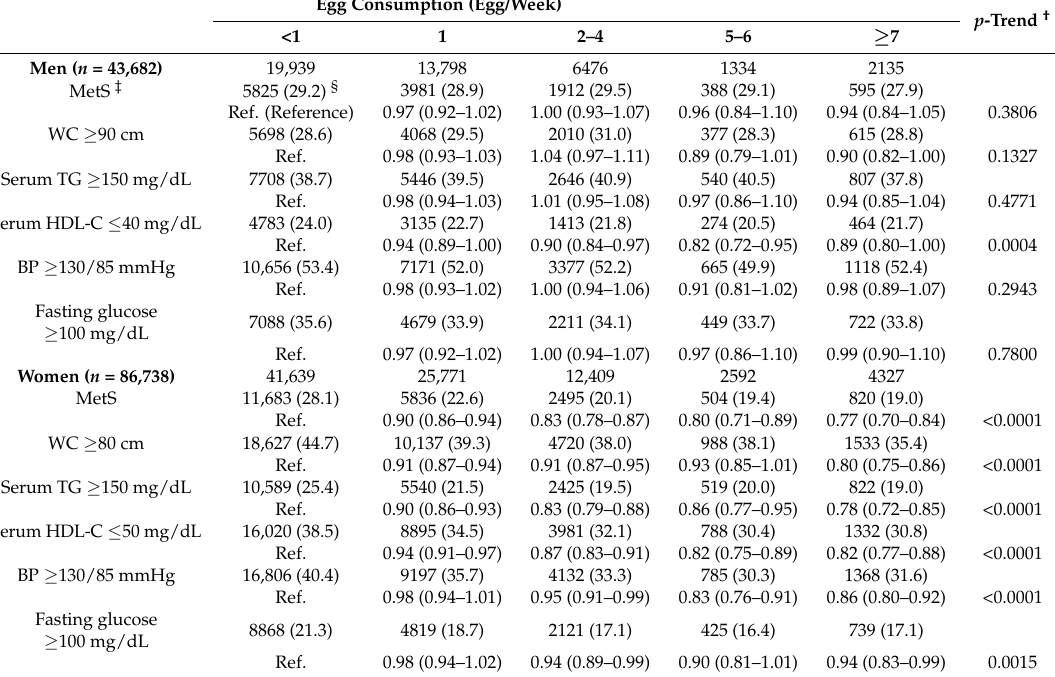
Table 2. Odd ratios (OR) * and 95% CI of metabolic syndrome and components according to egg